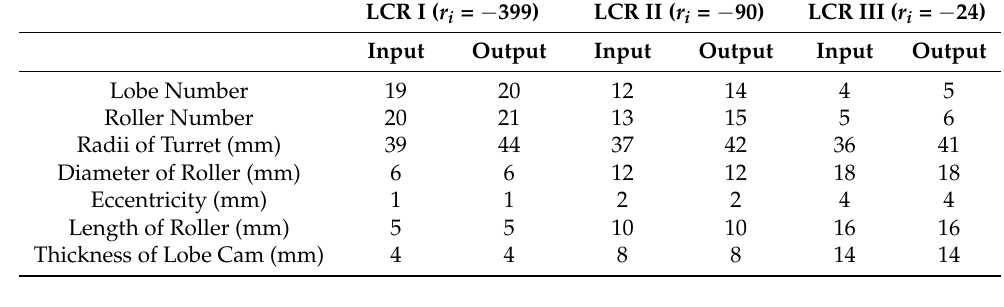
Table 2. Design parameters of three lobe cam reducers.